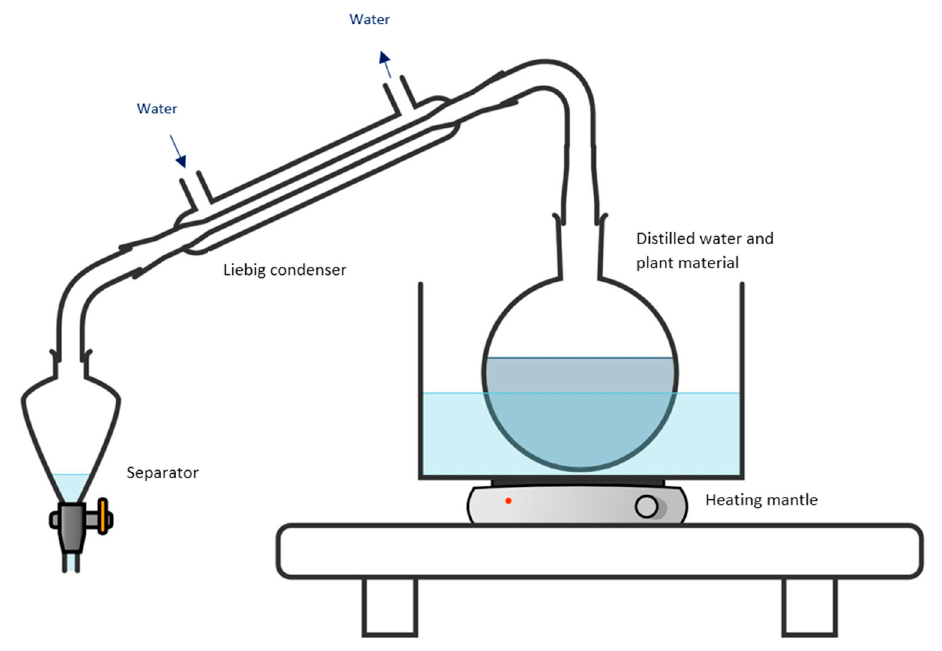
Figure 5. Schematic diagram of the hydrodistillation set-up. For cellulase-assisted hydrodistillation, the cellulase is in the flask with the distilled water and plant material. (Figure created by the authors: https://chemix.org/ (accessed on 10 October